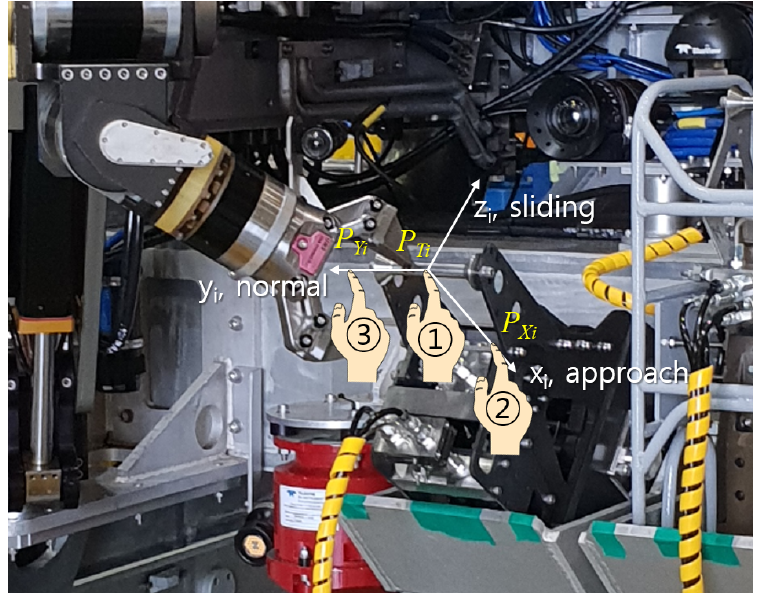
Figure 4. Manipulators and tools for cable